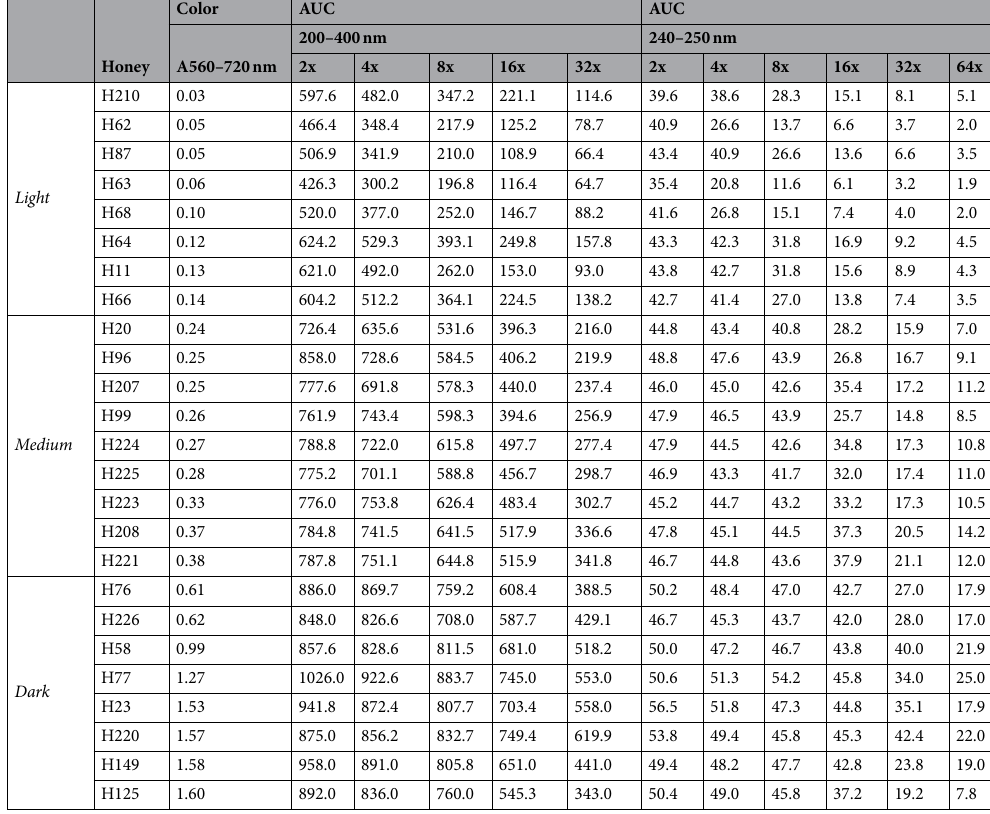
Table 2. Honey color and concentration of UV absorbing compounds, measured as AUC 200–400 nm and AUC 240–250 nm, versus honey